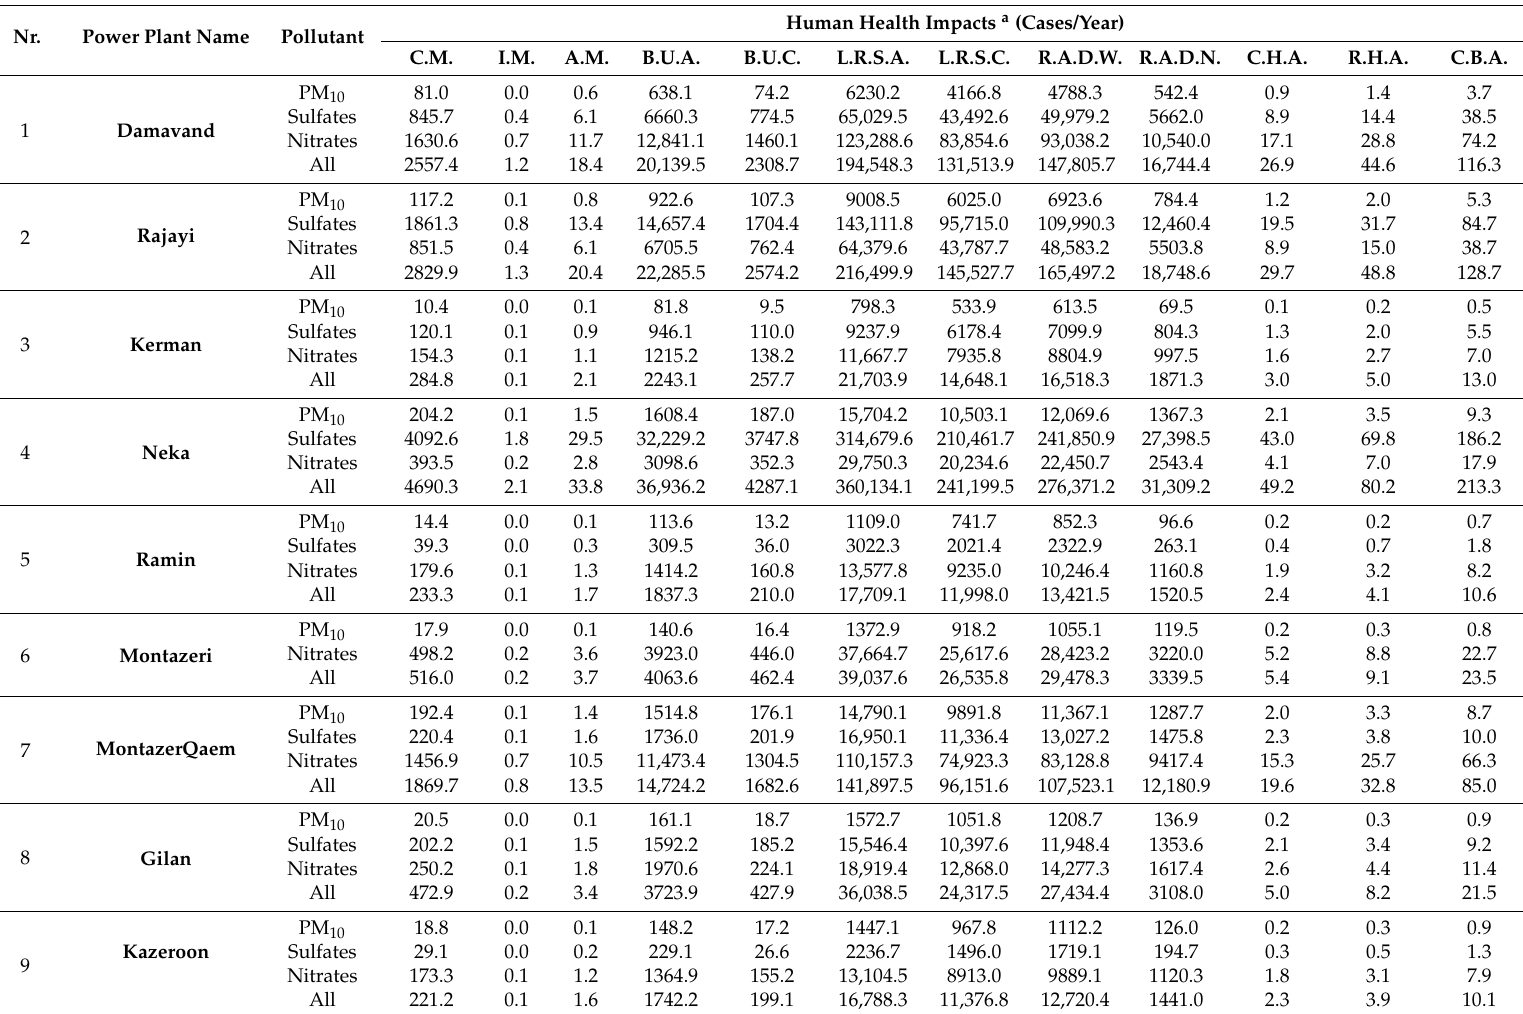
Table A4. Human health impacts from the 61 plants of Iran by type of